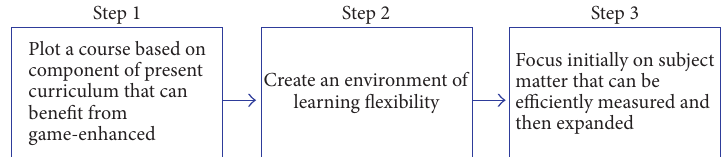
Figure 3: Curriculum integration.